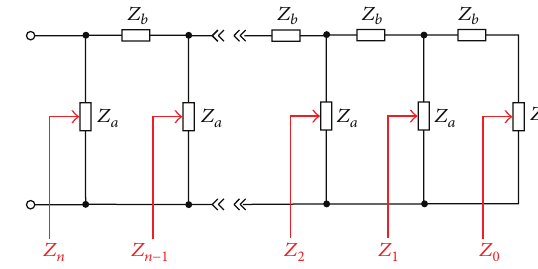
Figure 12: Complex impedance ladder network.